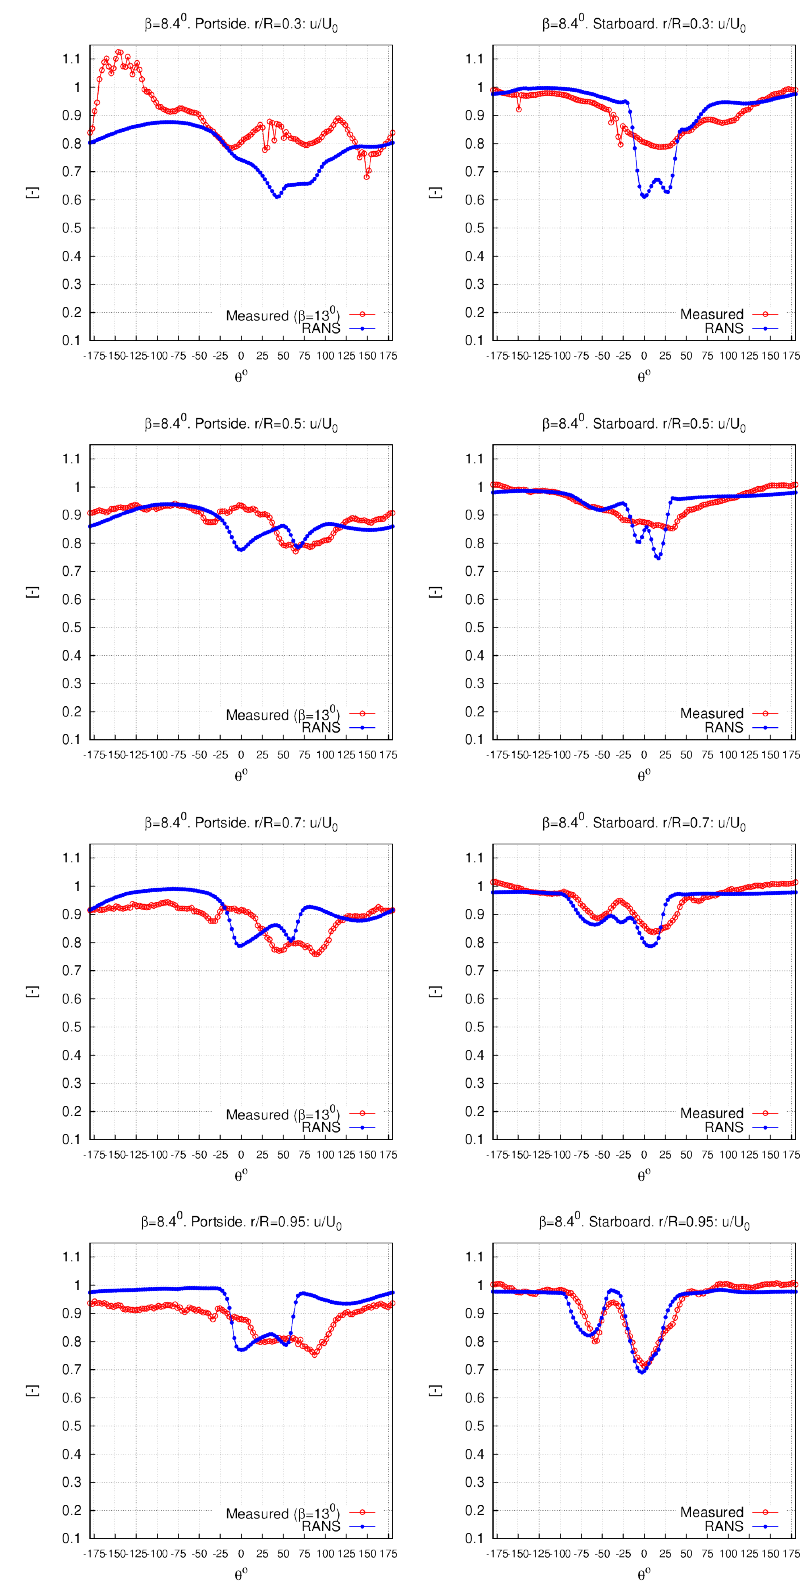
Figure 10. Nominal wake of the model hull in steady drift motion, starboard: axial velocity compo- nents by PIV (red plots) and RANS (blue plots) at key radial sections ( r / R = 0.3;0.5; 0.70;0.95 from top to bottom). ( Left ) portside propeller. ( Right ) starboard